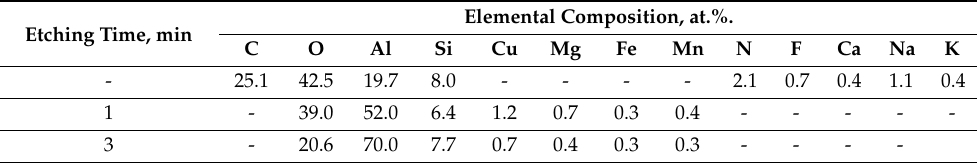
Table 3. Elemental composition at printed samples